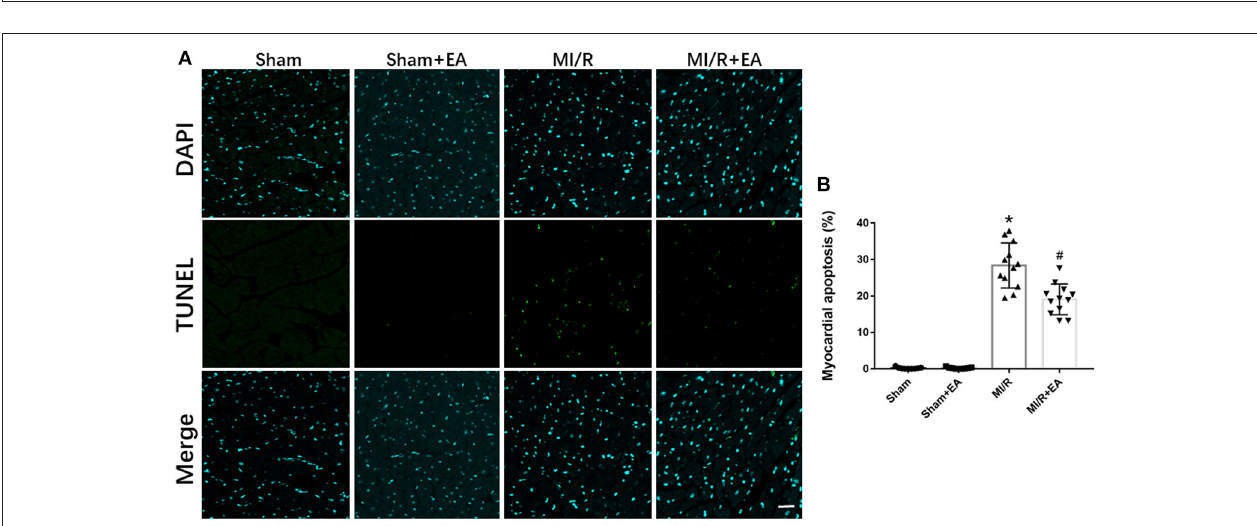
FIGURE 3 | The effects of EA pretreatment on myocardial apoptosis in MI/R-induced cardiac injury. (A) Representative images of myocardial apoptosis by TUNEL staining in MI/R-induced cardiac injury following EA pretreatment. (B) Myocardial apoptosis of mice from different groups. n = 3–4 for each group. Three to four hearts in each group were used for TUNEL staining, and five random fields in three sections of each heart were used for further analysis. Bar, 100 µ m. * P < 0.05 vs. Sham group, # P < 0.05 vs. MI/R group. EA, electroacupuncture; MI/R, myocardial ischemia/reperfusion.